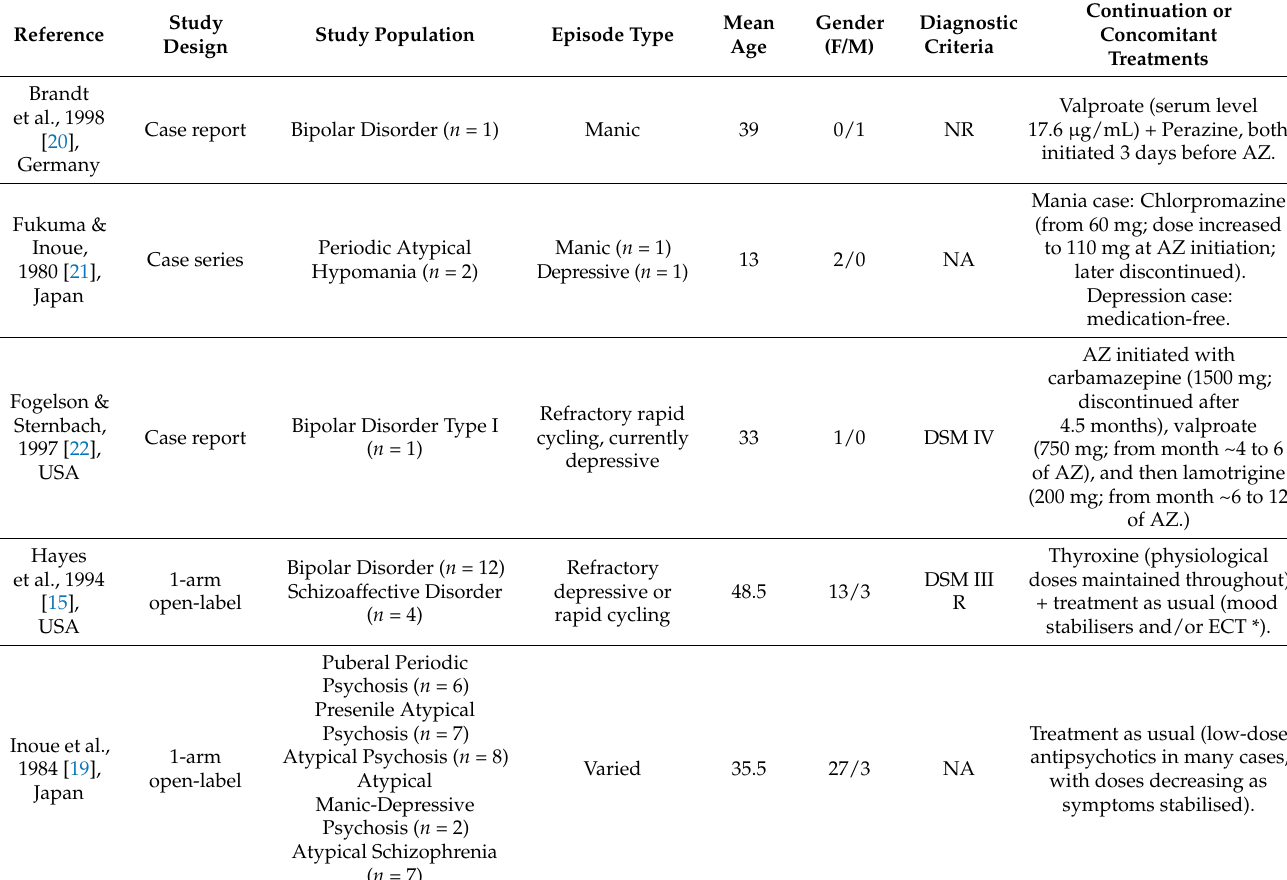
Table 1. Characteristics of included